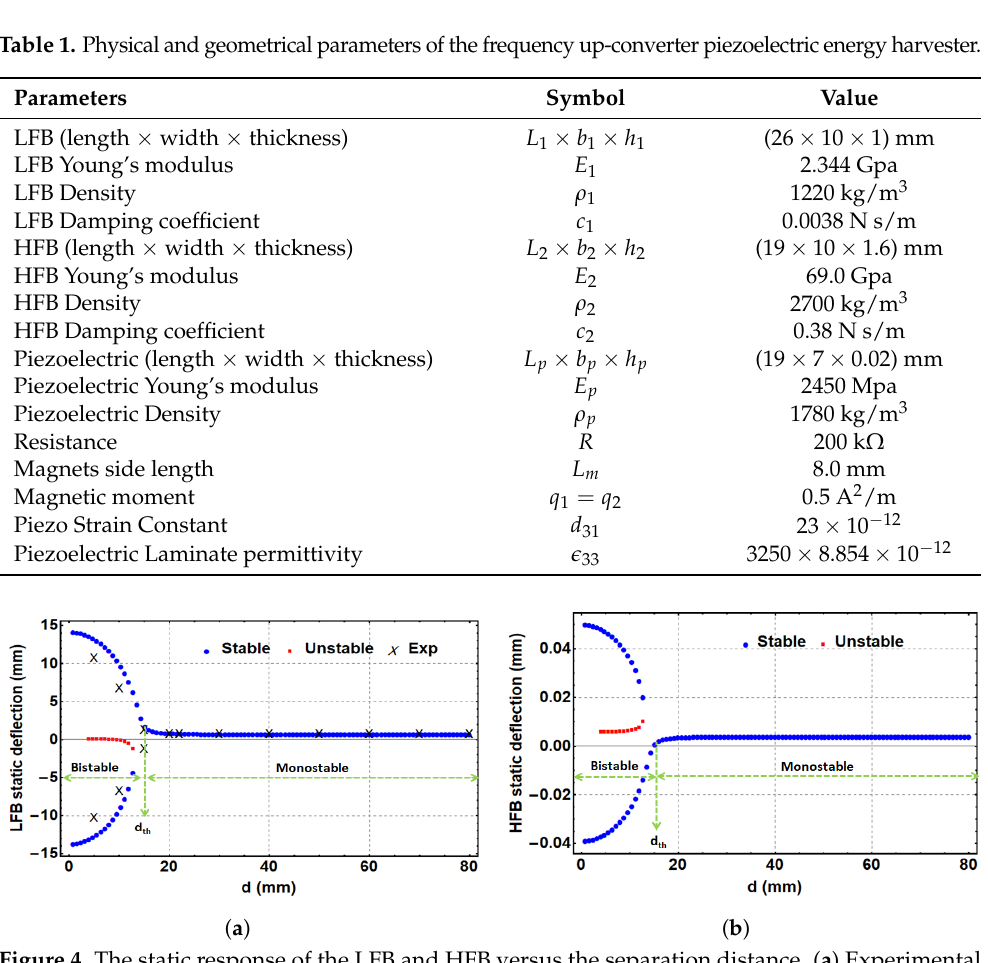
Figure 4. The static response of the LFB and HFB versus the separation distance. ( a ) Experimental and theoretical static response of the LFB, ( b ) theoretical response of the HFB. Threshold value, d th , found to be 15